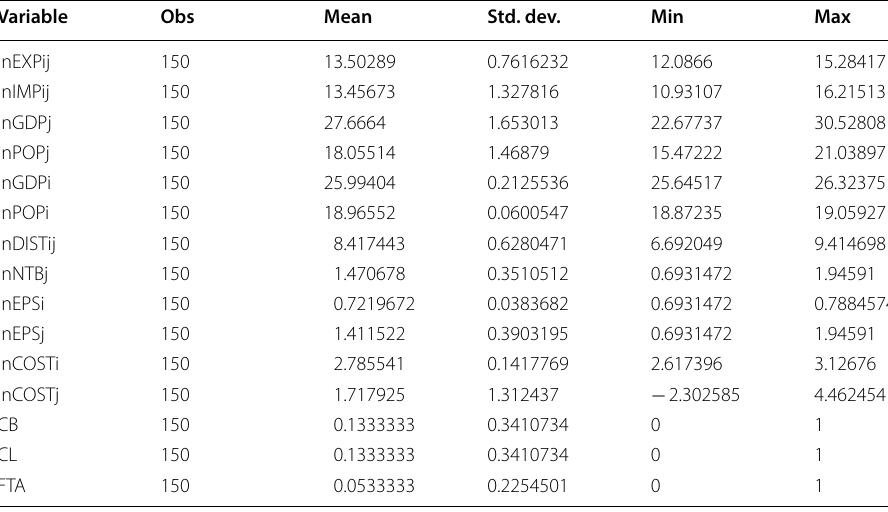
Table 7 Stringency of environmental regulations in the sample countries